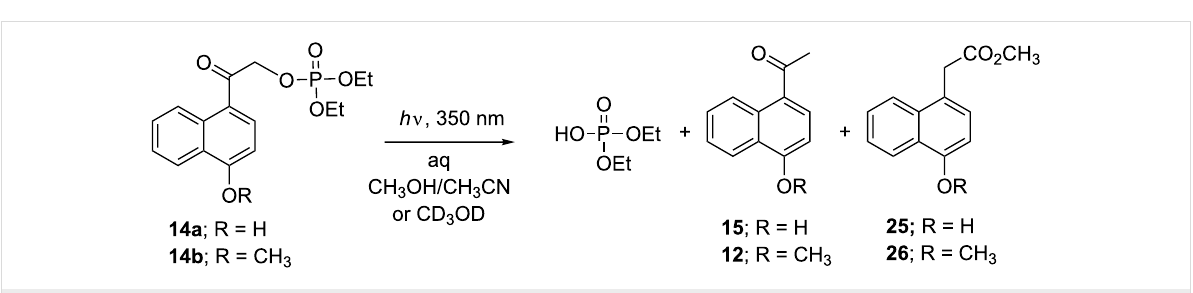
Scheme 3: Photolysis of 1,4-HNA and 1,4-MNA diethyl phosphates 14a and 14b in aq MeOH.